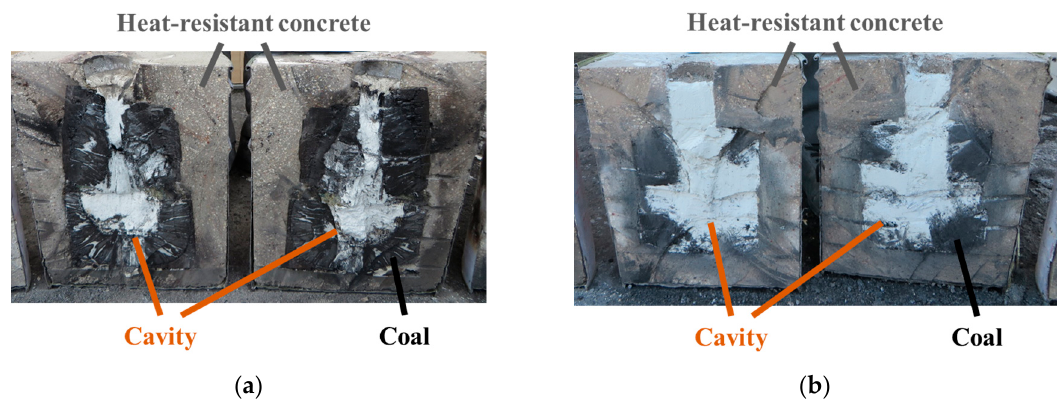
Figure 10. Cross-section study after the experiment: ( a ) Experiment 1; ( b ) Experiment 2.